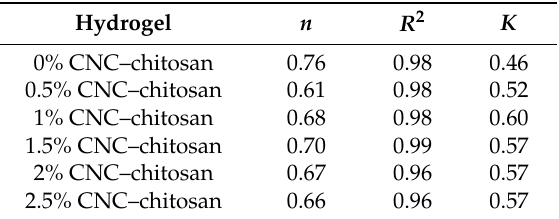
Table 2. Release kinetics of hydrogel in